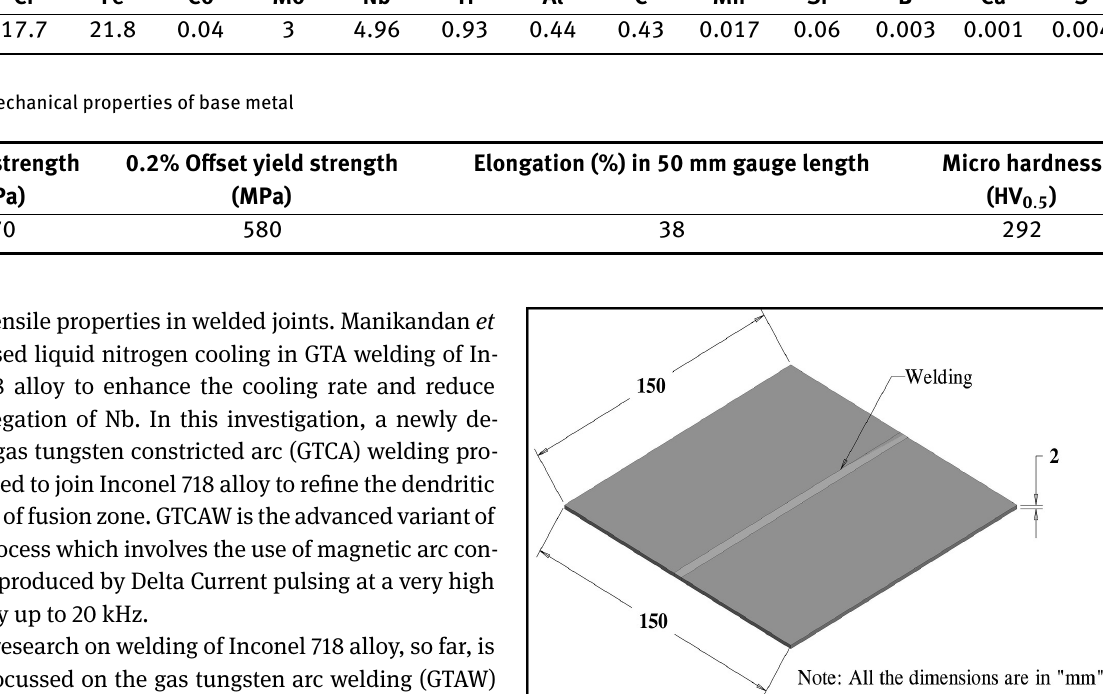
Table 1: Chemical composition (% by weight) of base metal Ni Cr Fe Co